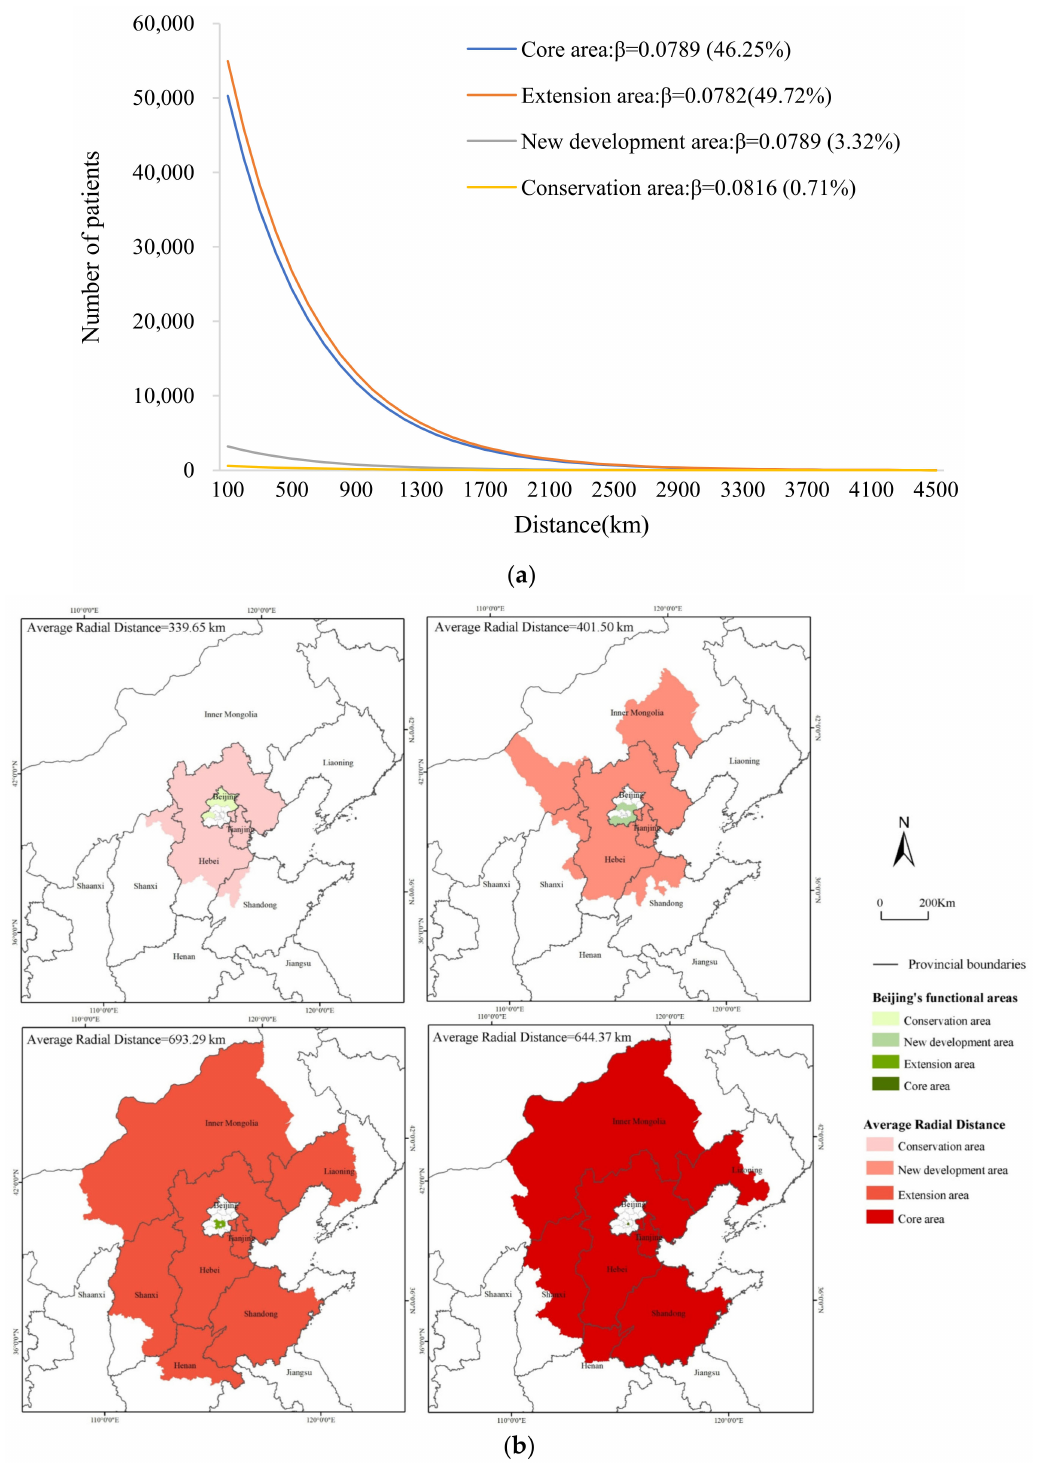
Figure 5. Hospital service utilization in different functional areas. ( a ) Fitting graph of the number of cross-regional patients according to distance in hospitals in different functional areas. ( b ) AR of hospitals in different functional